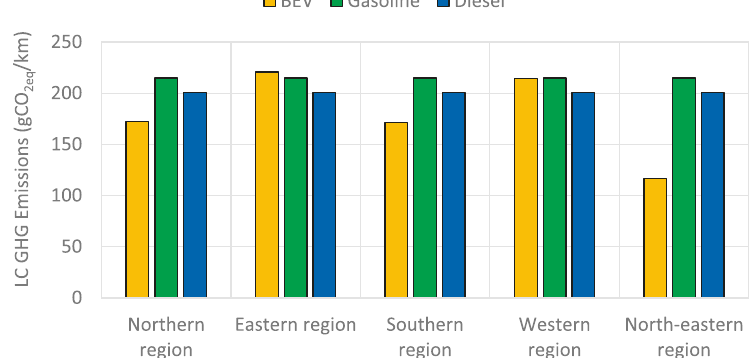
Fig. 9 The effects of adopting an alternative set of real-world correction factors on the life cycle (LC) GHG emissions of electric, gasoline, and diesel vehicles. Compared to the NEDC, the electric range of a battery-electric vehicle (BEV) is reduced by 30%, while the fuel consumption of combustion engine vehicles increased by 34% 76 . A total vehicle lifetime distance of 200,000 km was assumed for ( a ) Tata Nexon, ( b ) Mahindra Verito, and ( c ) Tata